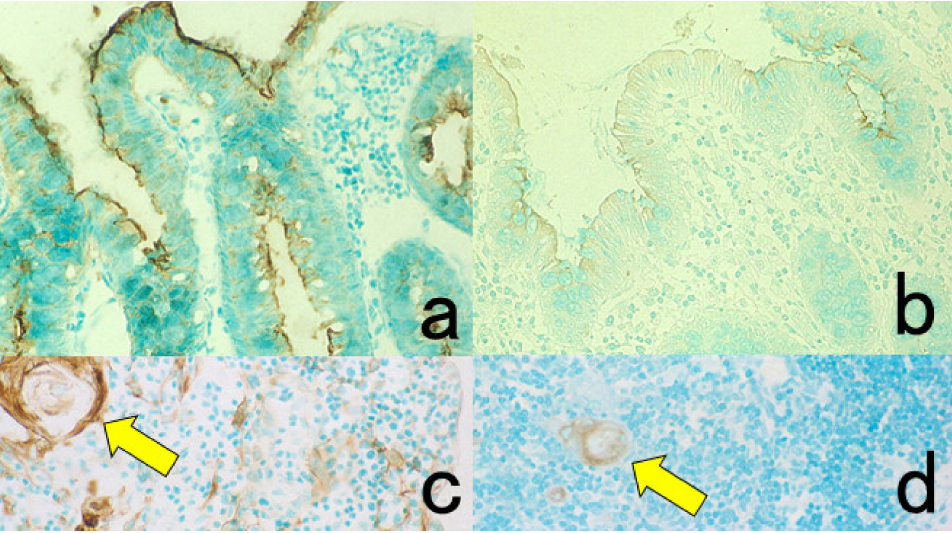
Figure 5. Antigenic deterioration in FFPE sections. Top panels ( a , b ): CEA in normal gastric mucosa. Bottom panels ( c , d ): Cytokeratin in normal infantile thymus. Left ( a , c ): paraformaldehyde-fixed frozen sections. Right ( b , d ): FFPE sections. Antigenicities of CEA and cytokeratin detected by polyclonal antibodies are evidently weakened after the FFPE process. Arrows indicate Hassall’s corpuscles in the thymic medulla. The nuclei are counterstained with methyl